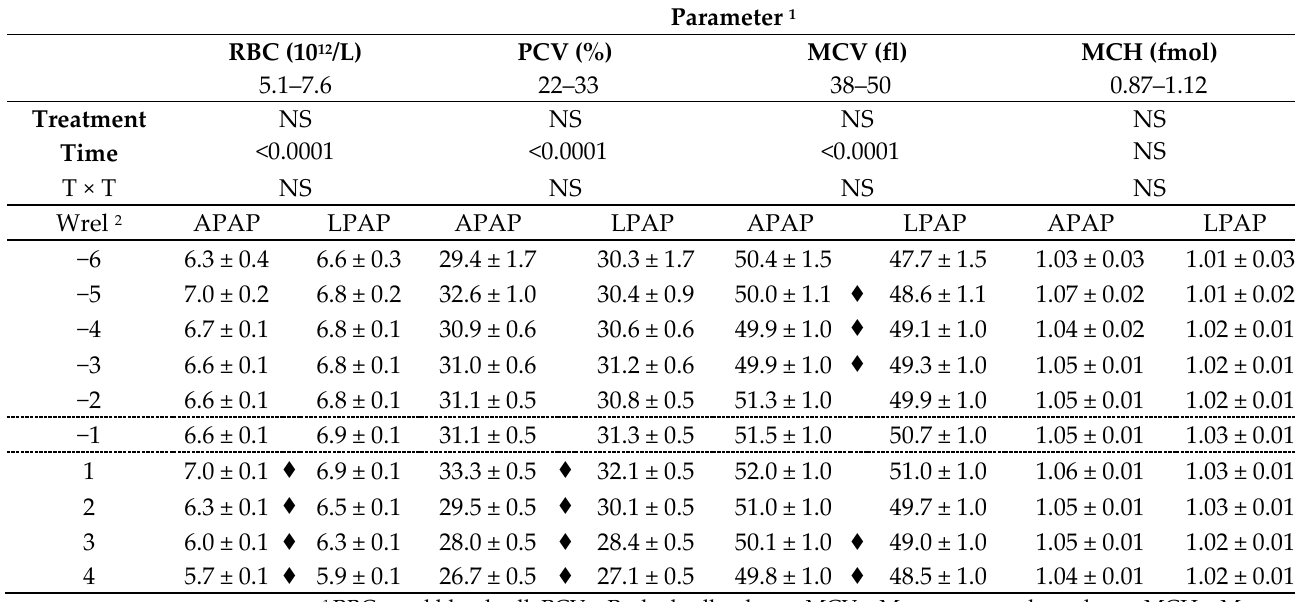
Table 5. Effect of antepartum phosphorus deprivation on RBC count, PCV, MCV and MCH in periparturient dairy cows.